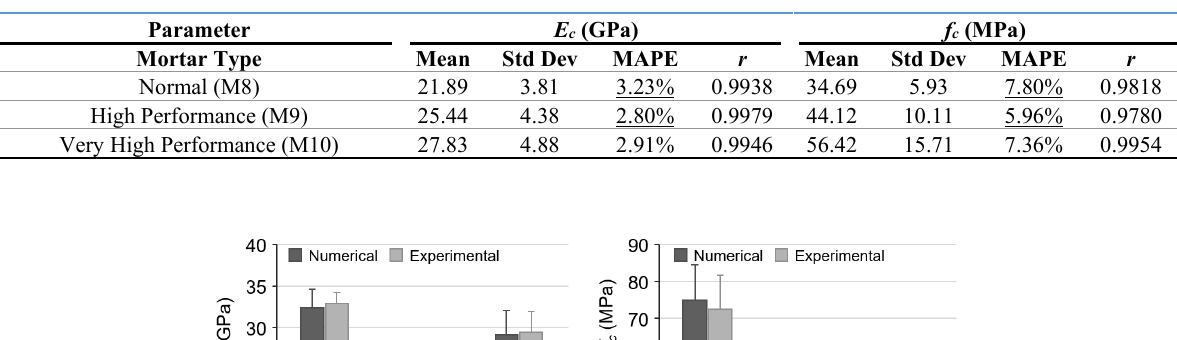
Table 7 N umerical results of the mechanical properties (Young’s modulus, E c ; and compressive strength, f c ) grouped under mortar type; including MAPE and Pearson correlation coefficient ( r ) statistical parameters.